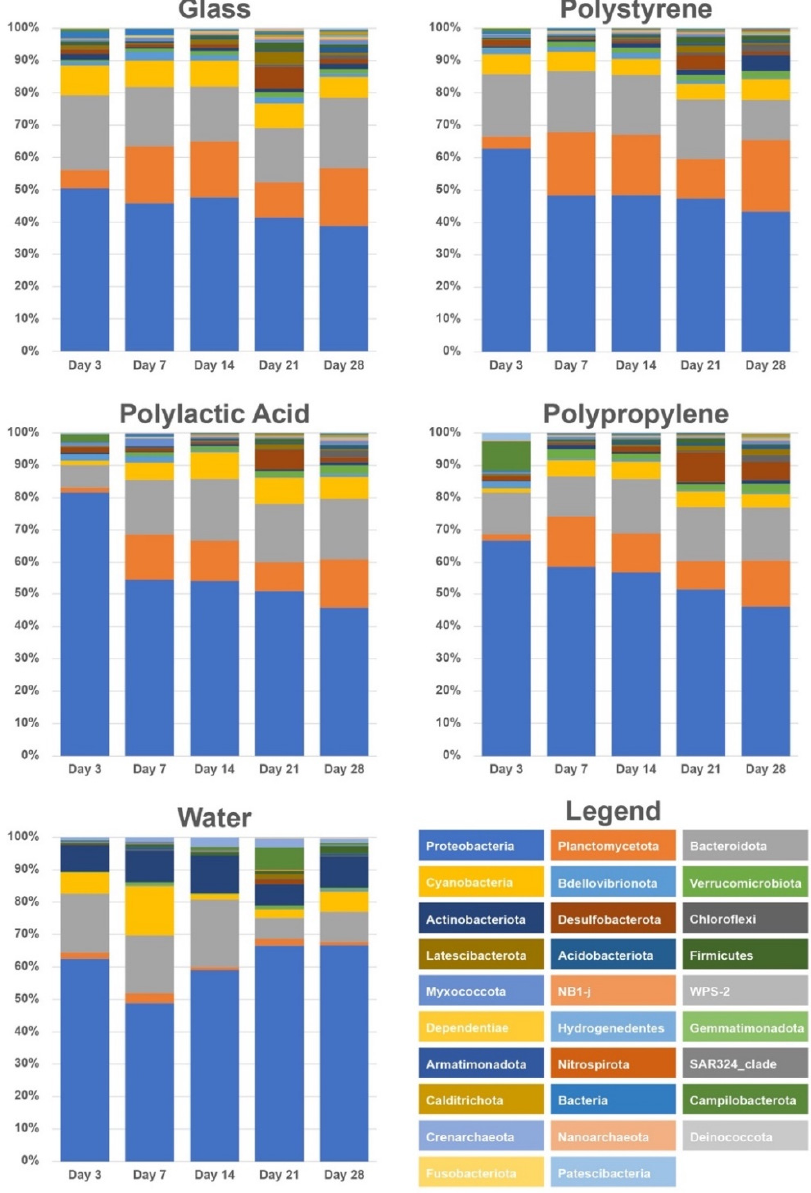
Figure 3. Relative abundance of major bacterial and archaeal lineages at the phylum level for microbial communities. The relative abundance was analyzed based on the 16S ribosomal RNA gene sequences obtained on days 3, 7, 14, 21, and 28.